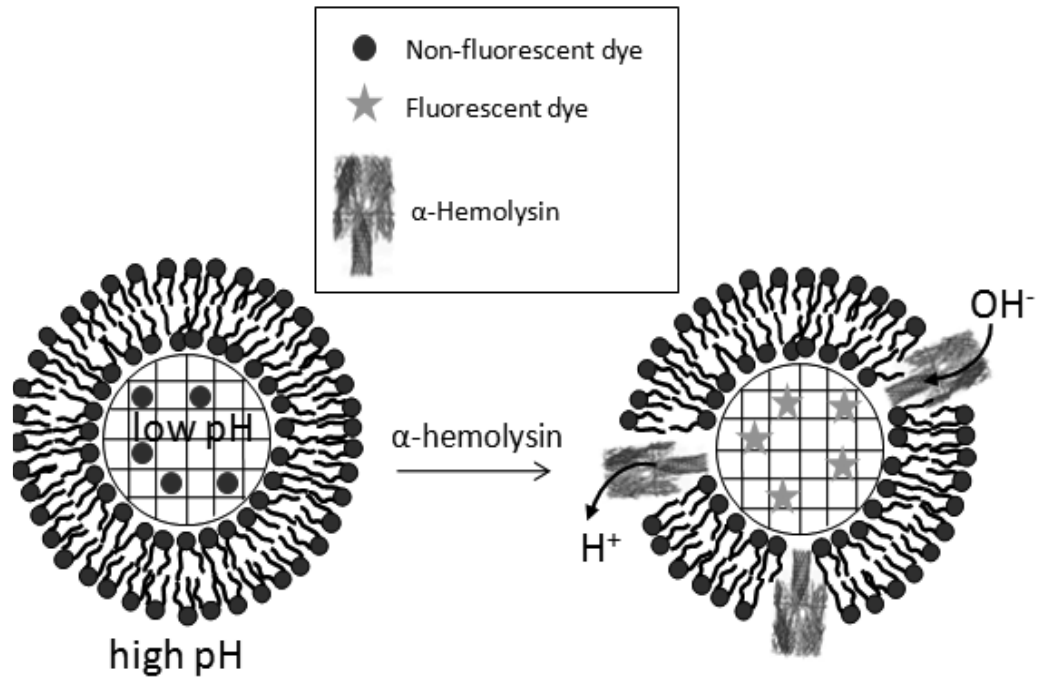
Figure 8. schematic of biosensing of pore-forming α -hemolysin by employing biomimetic porous microspheres enclosing a pH-sensitive fluorescent dye. The outside environment of the microspheres is basic while the inside is acidic which prevents fluorescence of the pH sensitive dye. Adding α -hemolysin forms pores within the SLB allowing ions to pass through the pores, thus increasing the internal pH in the microspheres resulting in detectable fluorescence of the pH sensitive